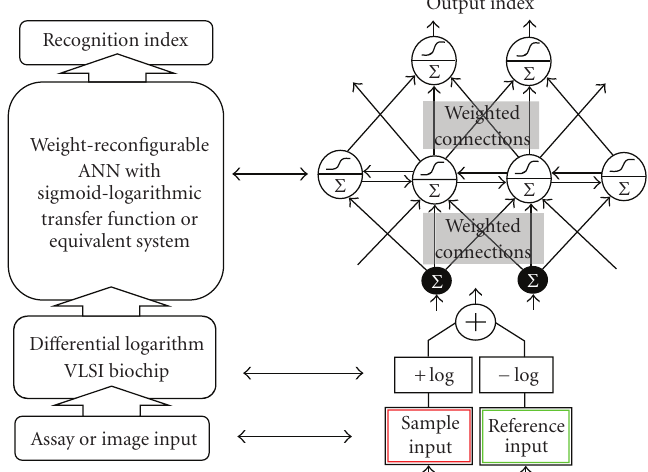
Figure 1: (a) Hierarchical diagram of the proposed biochip microsystem for genetic assay recognition. (b) Schematics of a three-layered ANN and the preceding di ff erential logarithm stage. The system of dual-labeled gene assay, dual-color beam module, and imaging lens is not shown in this schematic diagram. The thin-film color filters coated on top of the sample and reference channels are represented by the red and green